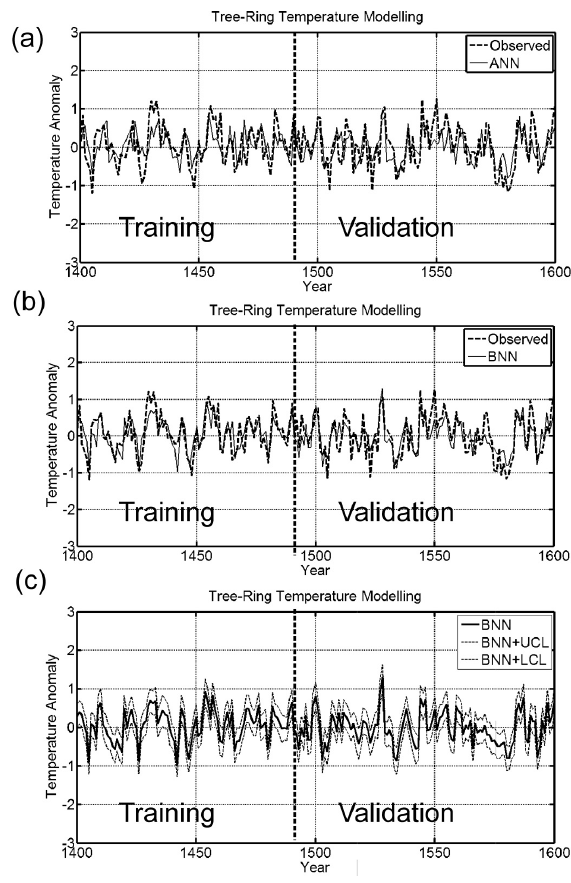
Fig. 7. One lag temperature anomaly reconstruction in the pe- riod (AD1400–1600) using (a) artificial neural network (ANN) (b) Bayesian neural network (BNN) (c) BNN with confidence level (CL) of